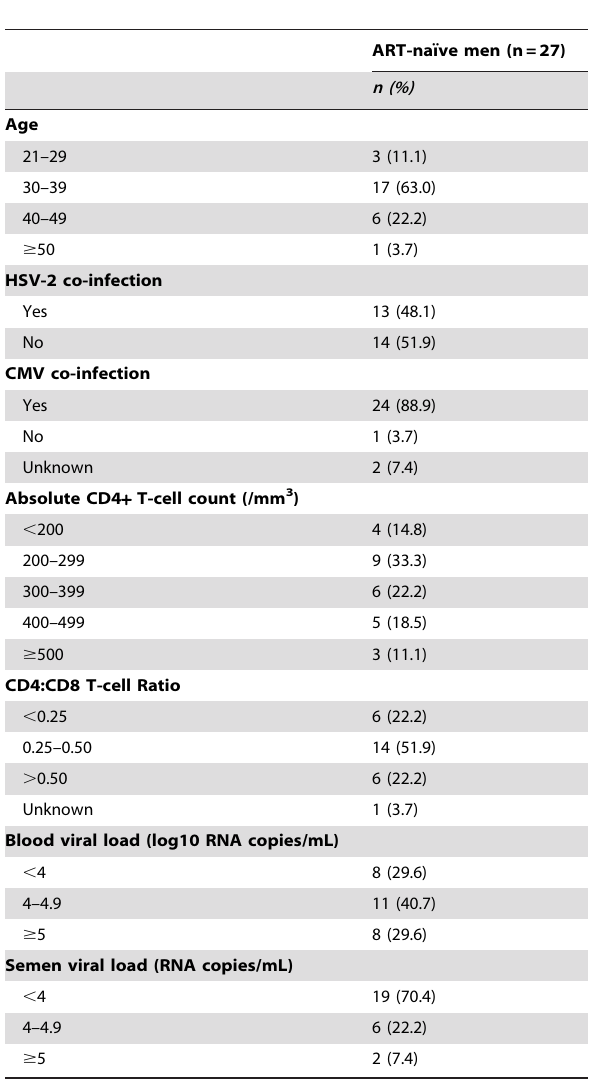
Table 1. Clinical parameters of the HIV-positive participants at baseline, prior to initiation of antiretroviral